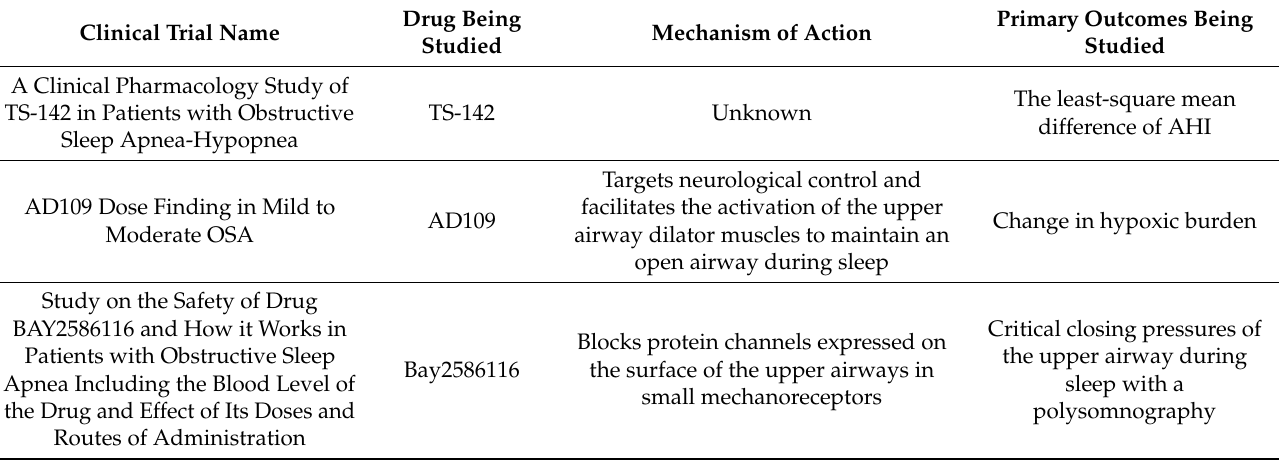
Table 2. Current Clinical Trials Involving Medication Management of Obstructive Sleep Apnea Have Recently Been Completed or